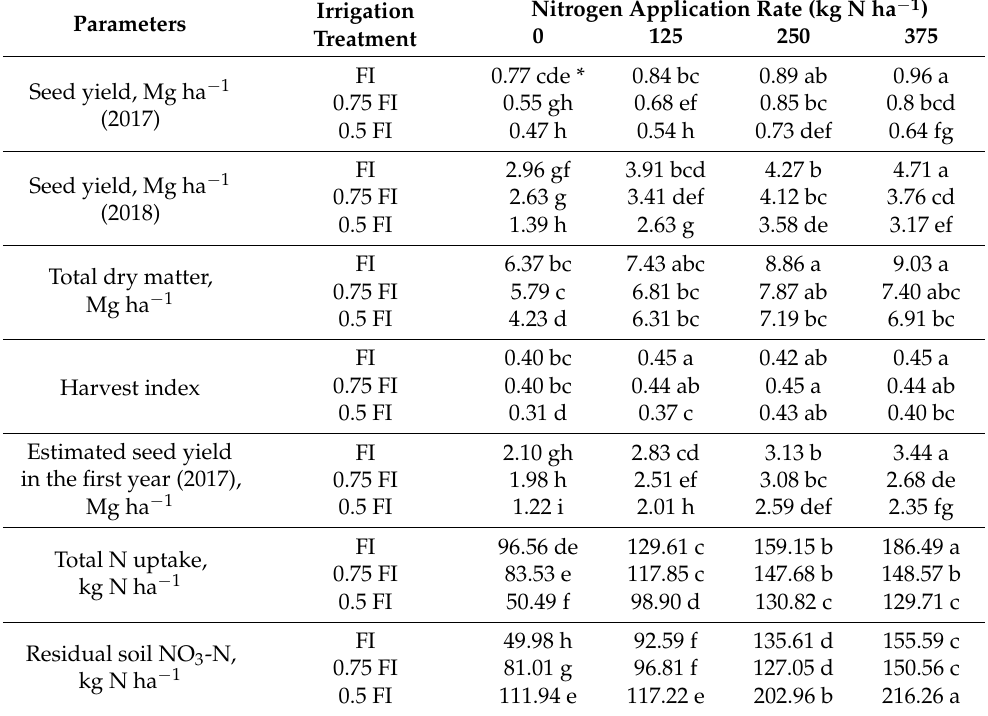
Table 2. Seed yield (Mg ha − 1 ), the two-year mean of total dry matter (Mg ha − 1 ), harvest index and estimated seed yield in the first year’, hypothetically discarding the pest and unfavorable air temperature (Mg ha − 1 ), total N uptake, (kg N ha − 1 ), and residual soil NO 3 -N, (kg N ha − 1 ) in different N application rates and irrigation